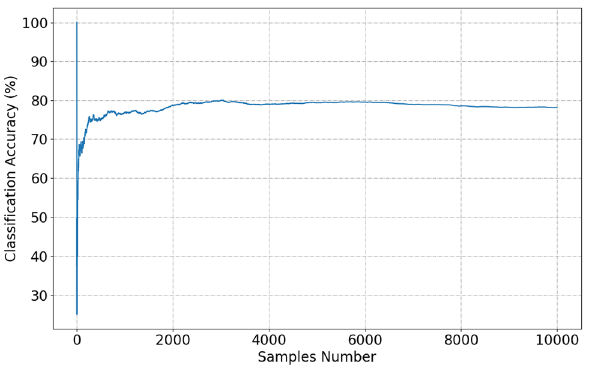
Figure 7. Classification accuracy in a large sample size experiment. The modulation signal of each experiment is randomly